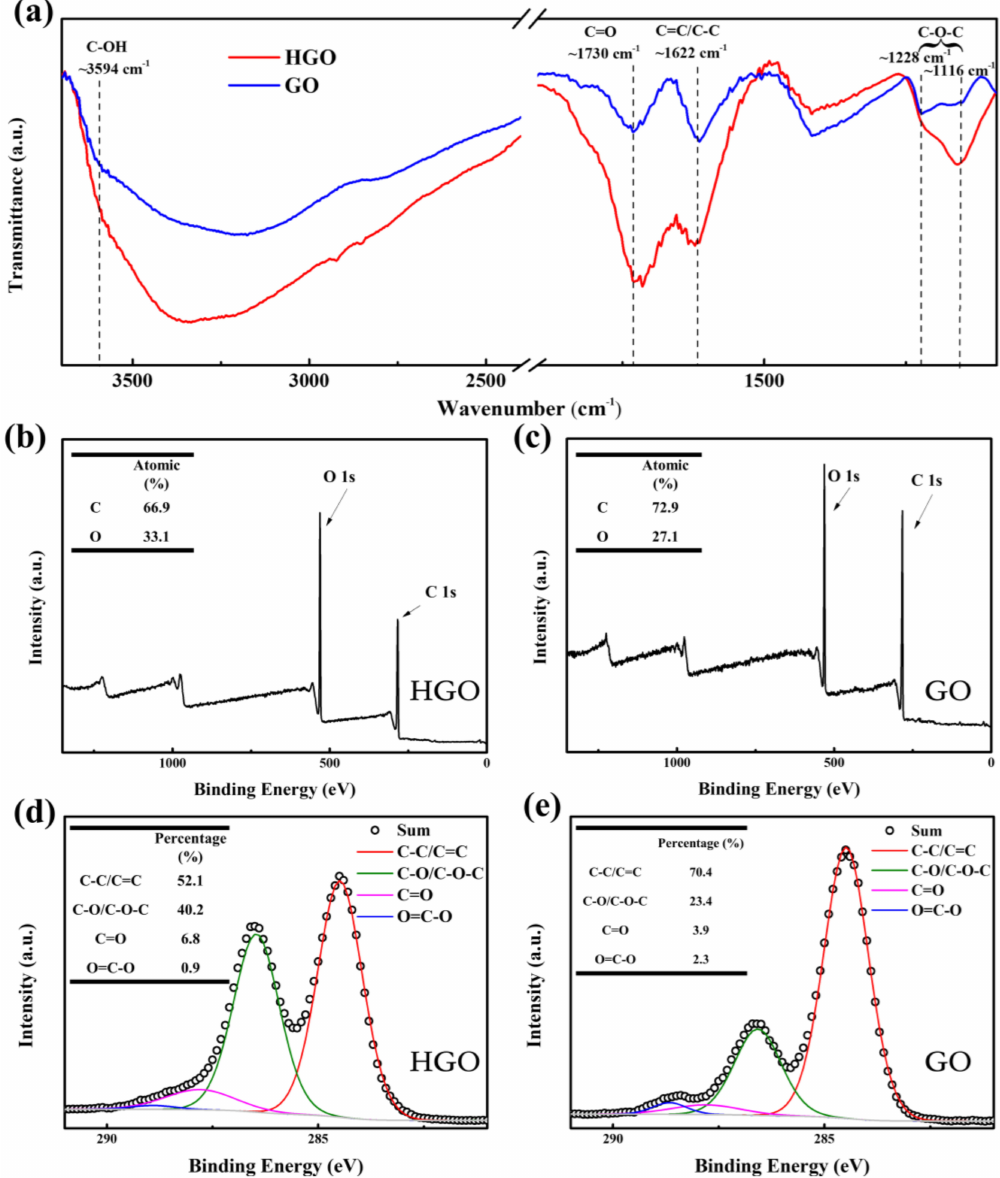
Figure 4. ( a ) The normalized Fourier transform infrared (FTIR) spectroscopy of GO and HGO membranes. ( b , c ) The full-scan X-ray photoelectron spectroscopy (XPS) of HGO and GO; inset is the atomic percentage of C and O. ( d , e ) C1s XPS spectra of HGO and GO; inset is the proportion of oxygen-containing functional